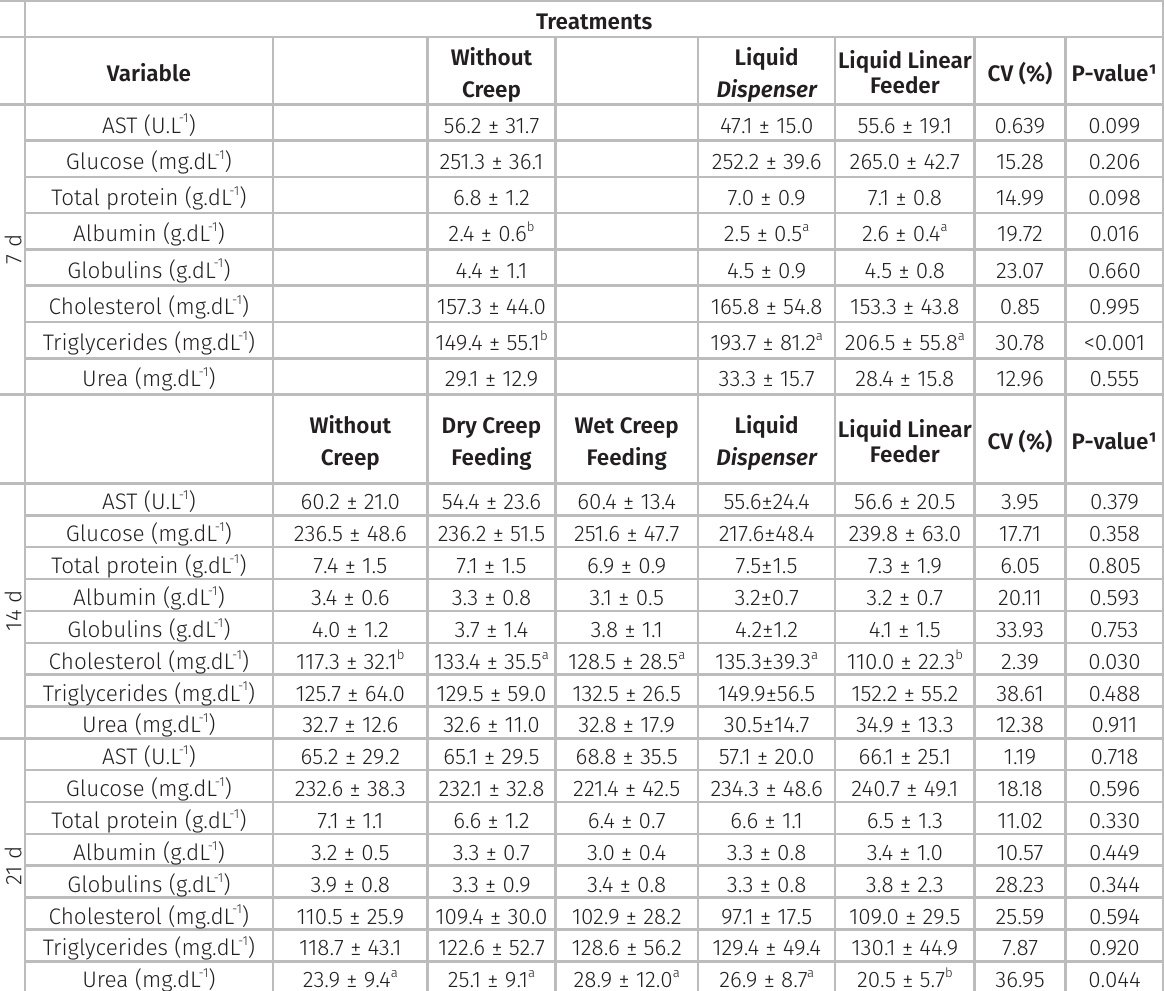
Table III. Serum biochemical of the piglets (n= 20 per treatment) of 7, 14 and 21 days under different feed